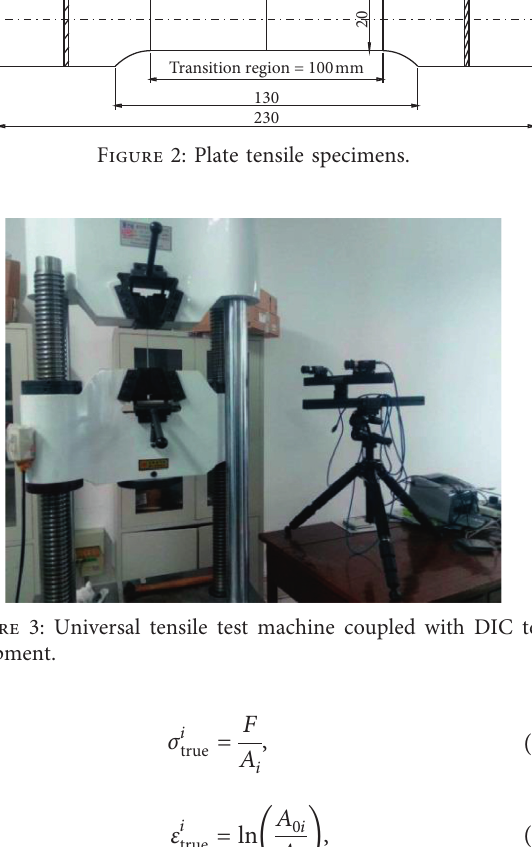
Figure 4: Curves of true stress-plastic strain with TRB